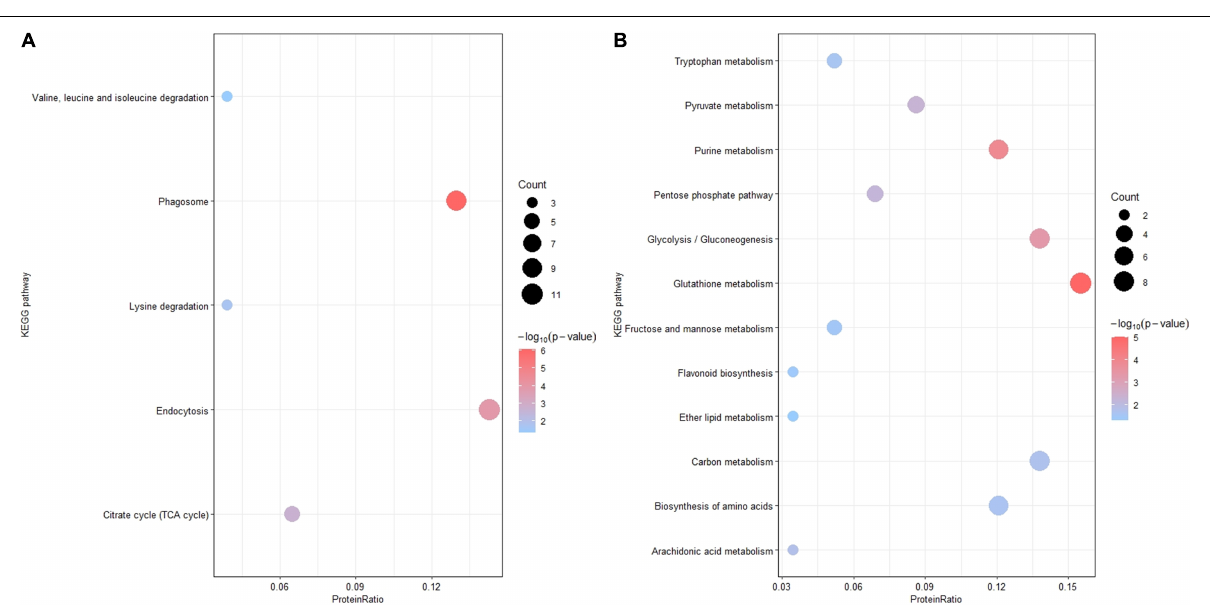
the Ras protein OsRIC1 (P40392) and unclassified